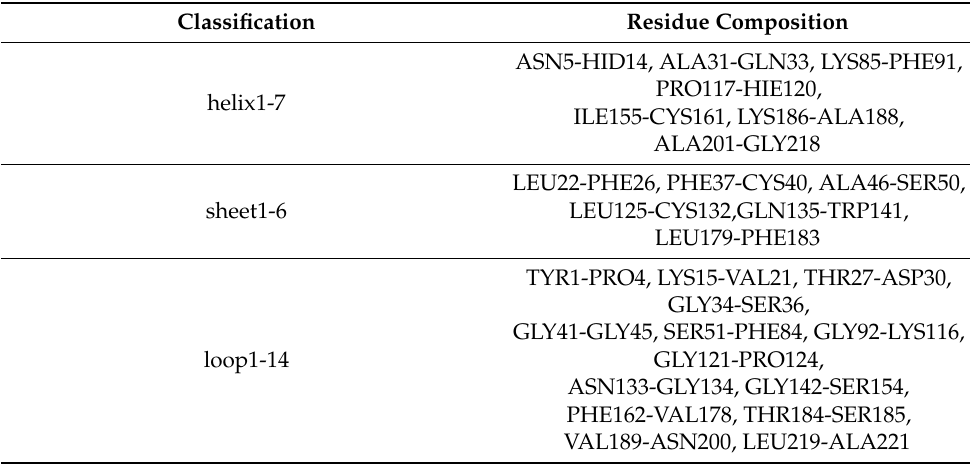
Table A1. shows the speci fi c residue divisions of secondary structures.